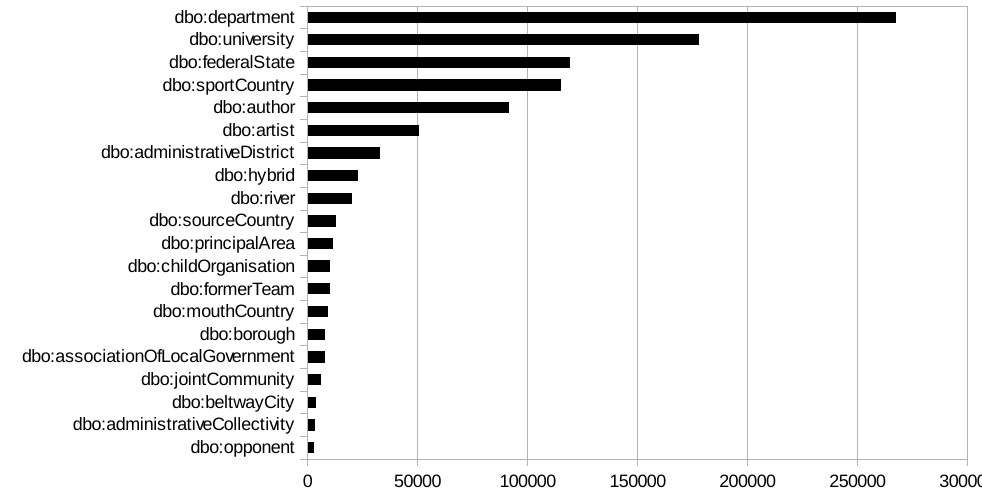
Figure 4. 20 most frequent relations extracted from English abstracts.